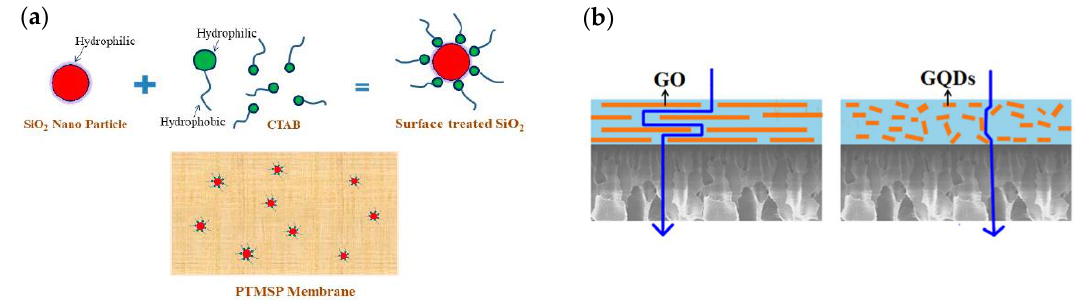
Figure 2. ( a ) Surface modification of silica NPs and the PTMSP/silica MMM. Reproduced with permission from [40], published by MDPI, 2011. ( b ) Comparison between permeation of GO filled MMM and GOQDs filled MMM. Reproduced with permission from [43], published by Elsevier, 2018.